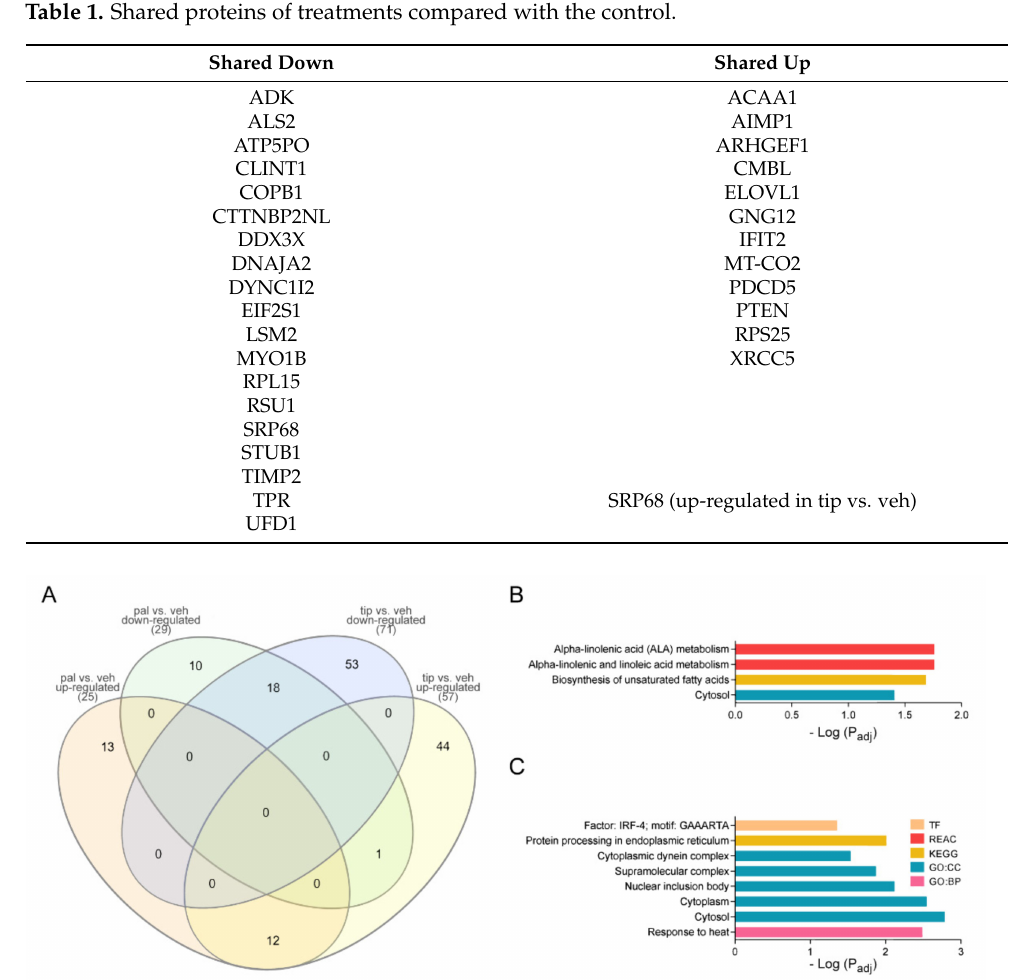
Figure 5. Analysis of the intersect proteins in pal vs. veh and tip vs. veh. ( A ) Venn diagram of pal and tip vs. veh. In the diagram, tip vs. veh has 44 up-regulated unique proteins and 53 down- regulated unique proteins; pal vs. veh has 13 up-regulated unique proteins and 10 down-regulated unique proteins; between the comparisons, there are 12 up-regulated y 18 down-regulated shared. ( B ) Functional enrichment of shared up-regulated proteins. ( C ) Functional enrichment of shared down-regulated